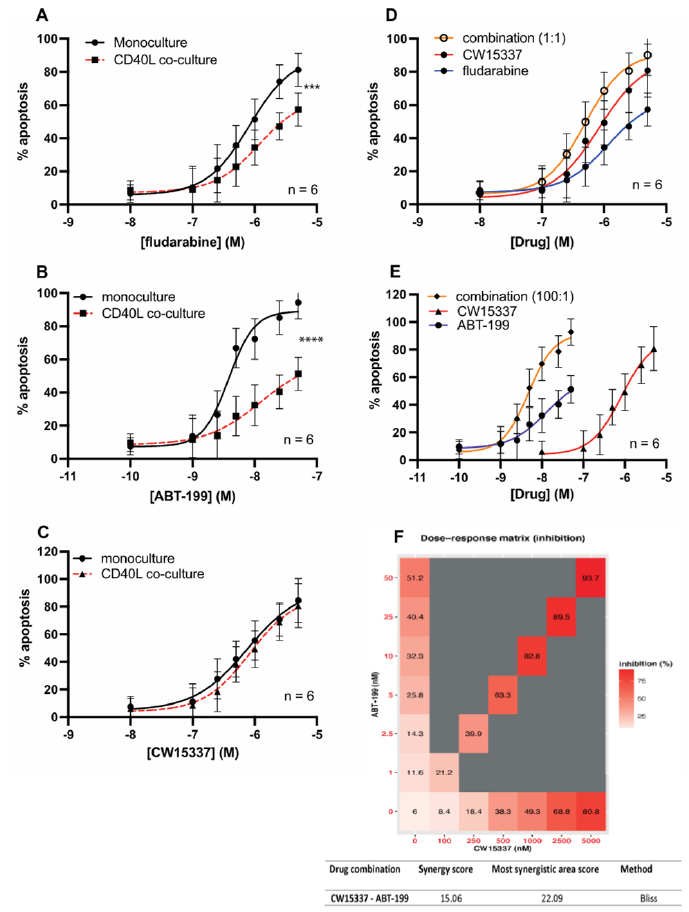
Figure 6. CW15337 is synergistic with fludarabine and ABT-199 in the setting of CD40L 3T3 co-culture. Primary CLL cells showed a marked increase in resistance to ( A ) fludarabine and ( B ) ABT-199 when co-cultured on CD40L 3T3 cells. ( C ) In contrast, the sensitivity to CW15337 was not significantly affected by CD40L co-culture. The combination of CW15337 with ( D ) fludarabine and ( E ) ABT-199 showed synergistic interactions. ( F ) The combination of CW15337 and ABT-199 (100:1) was shown to be particularly synergistic under CD40L co-culture conditions, using SynergyFinder software (https://synergyfinder.fimm.fi, accessed on 30 January 2022). BLISS scores ≥ 10 indicate synergy, the average synergy score of CW15337 and ABT-199 was 15.06. **** p < 0.0001, *** p <